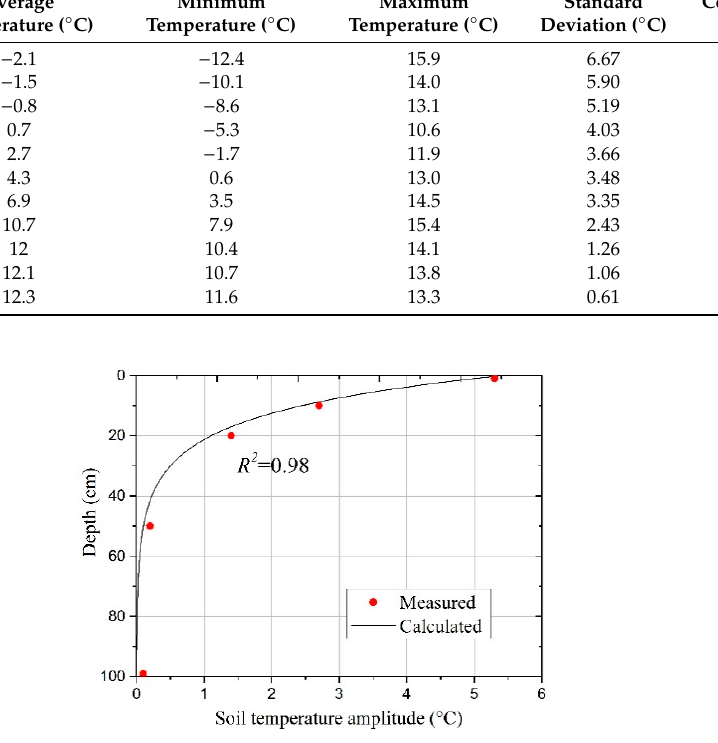
Figure 5. Changes in the diurnal soil temperature amplitude as a function of depth.